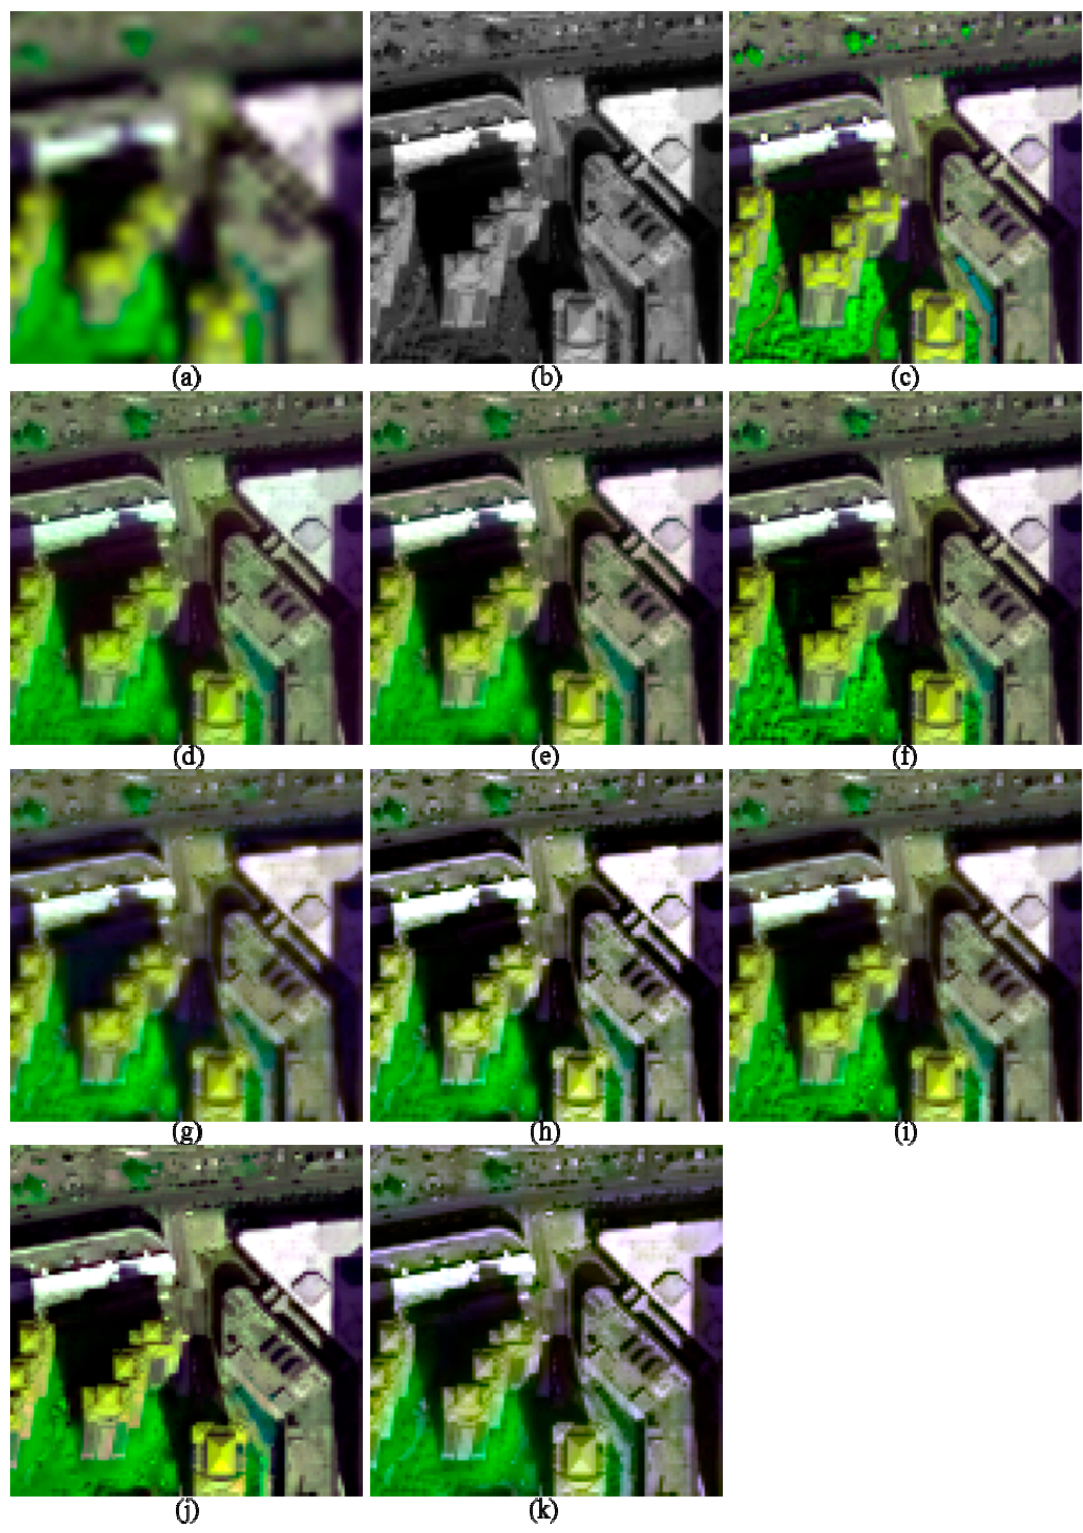
Figure 3. The degraded and 2-m fused images of I1, shown in band 5-7-2 composition. ( a ) 8-m MS; ( b ) 2-m PAN; ( c ) True 2-m MS; ( d ) GS; ( e ) GSA; ( f ) HR; ( g ) HCS; ( h ) ATWT; ( i ) GLP_ESDM; ( j ) GLP_ECBD; and ( k ) NSCT_M2.